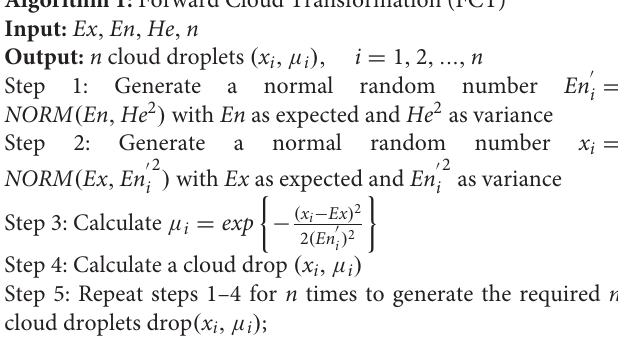
Algorithm 1: Forward Cloud Transformation (FCT)